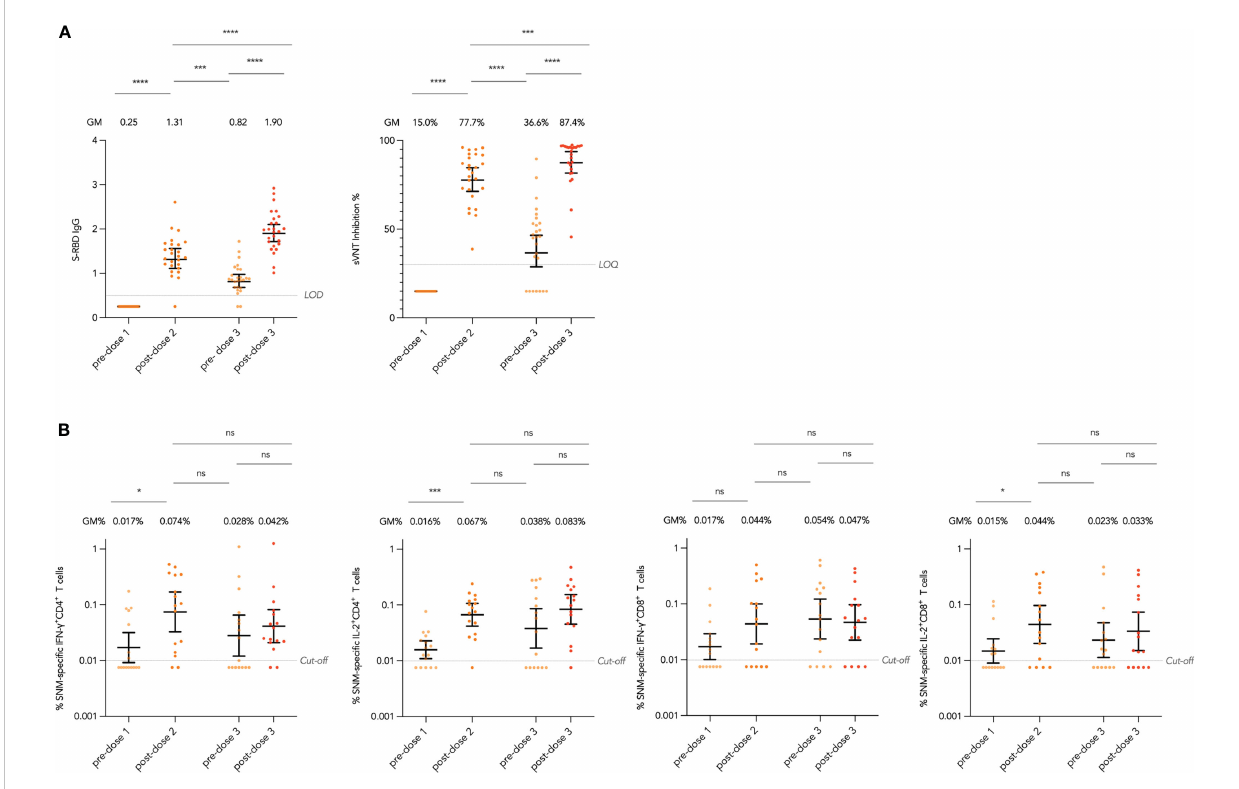
FIGURE 1 Longitudinal humoral and cellular immunogenicity in healthy evaluable adolescents receiving 3 doses of CoronaVac. (A) Longitudinal analysis of Spike receptor-binding domain (S-RBD) IgG OD450 values and surrogate virus neutralisation test (sVNT) inhibition % in evaluable adolescents. (B) Longitudinal analysis of total Spike (S), Nucleocapsid (N) and Membrane (M) protein-speci fi c interferon- g (IFN- g )+ and interleukin-2 (IL-2)+ CD4+ and CD8+ T cells responses in evaluable adolescents. Geometric means (GM) are shown with centre lines and stated above each column, with corresponding 95% con fi dence intervals shown by error bars. Samples from the same participant were paired across timepoints and compared with paired t test after natural logarithmic transformation with p-values denoted (*, P<0.05; ***, P<0.001; ****, P<0.0001; ns, not signi fi cant). Limits of detection and quanti fi cation (LOD and LOQ) and cut-offs were drawn as grey